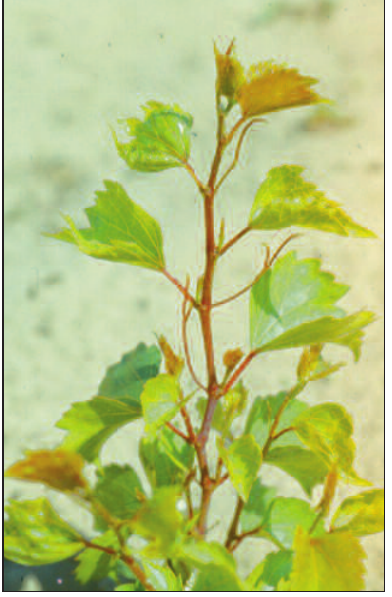
Figure 15. Fleck (GFkV) – clearing of the veinlets and deformation of the leaves.